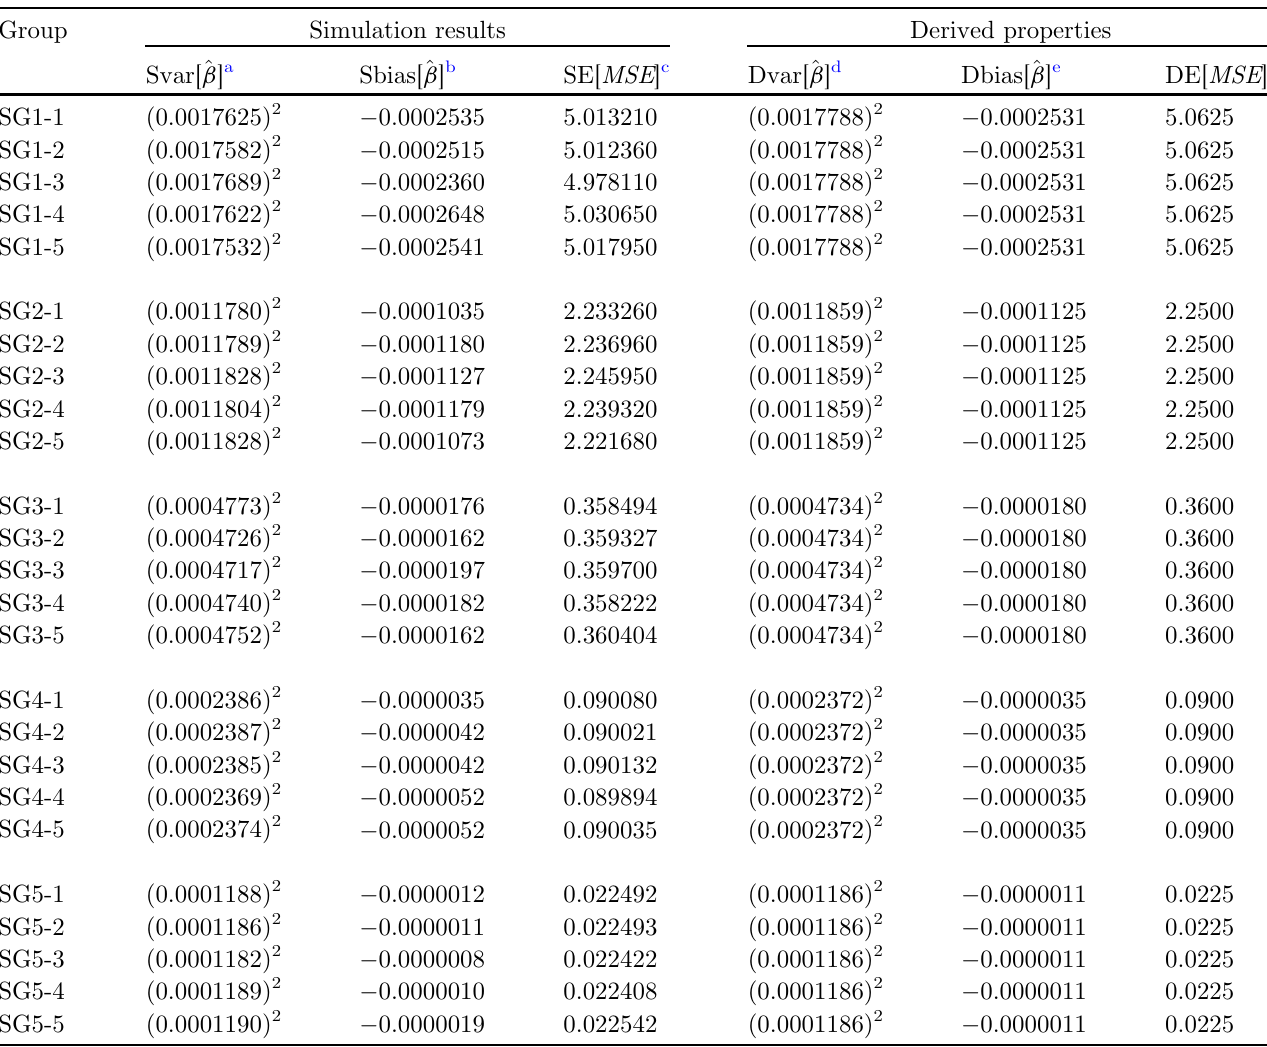
Table 1. Simulation results and theoretically derived properties.